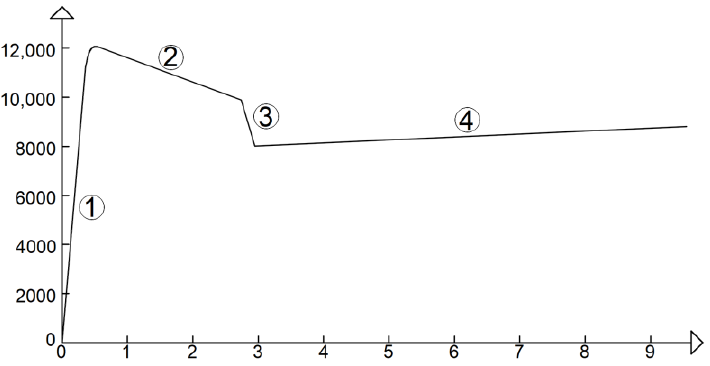
Figure 21. Simplified force – displacement curve of uniaxial tensile test on C-F/TRC specimens. The numbers 1 – 4 indicate the four stages of the curve.